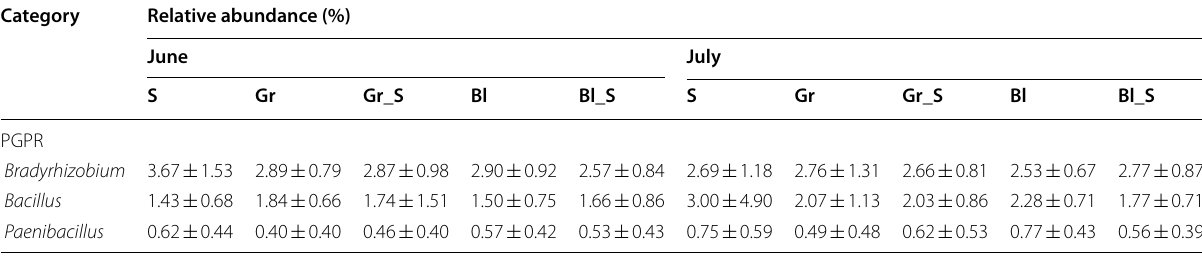
No significant difference between groups ( P > 0.05)